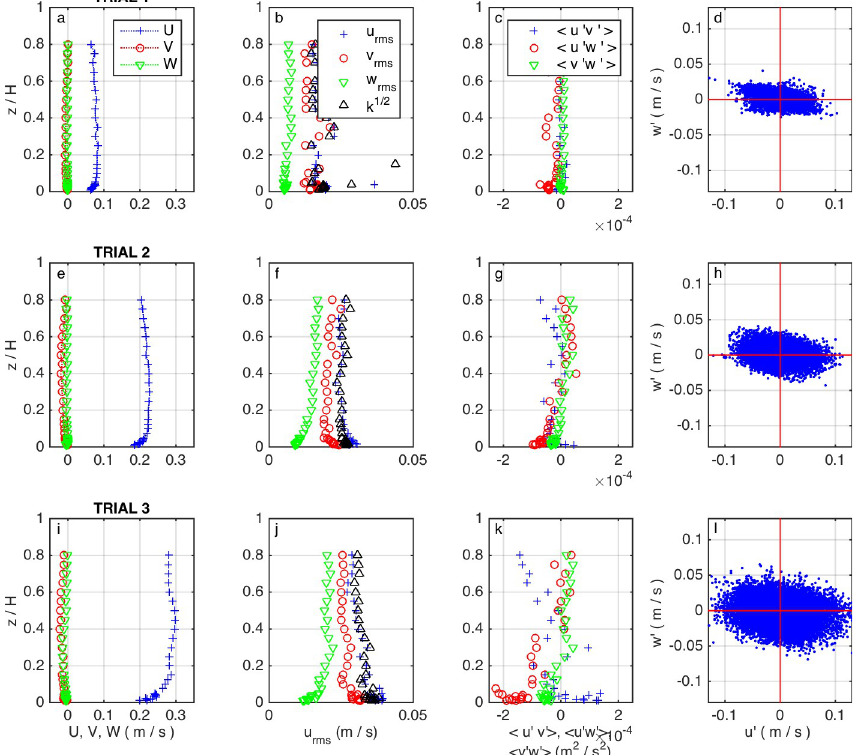
Fig 3. Flow and turbulence conditions over the flume’s straight test section in each trial. (a,e,i) Mean velocities U , V , W . (b,f,j) turbulence intensities u rms , v rms , w rms and turbulent kinetic energy k . (c,g,k) Reynolds stresses h u 0 v 0 i , h u 0 w 0 i , h v 0 w 0 i . (d,h,l) Quadrant analysis from instantaneous velocity measurements 1 mm above the bed.